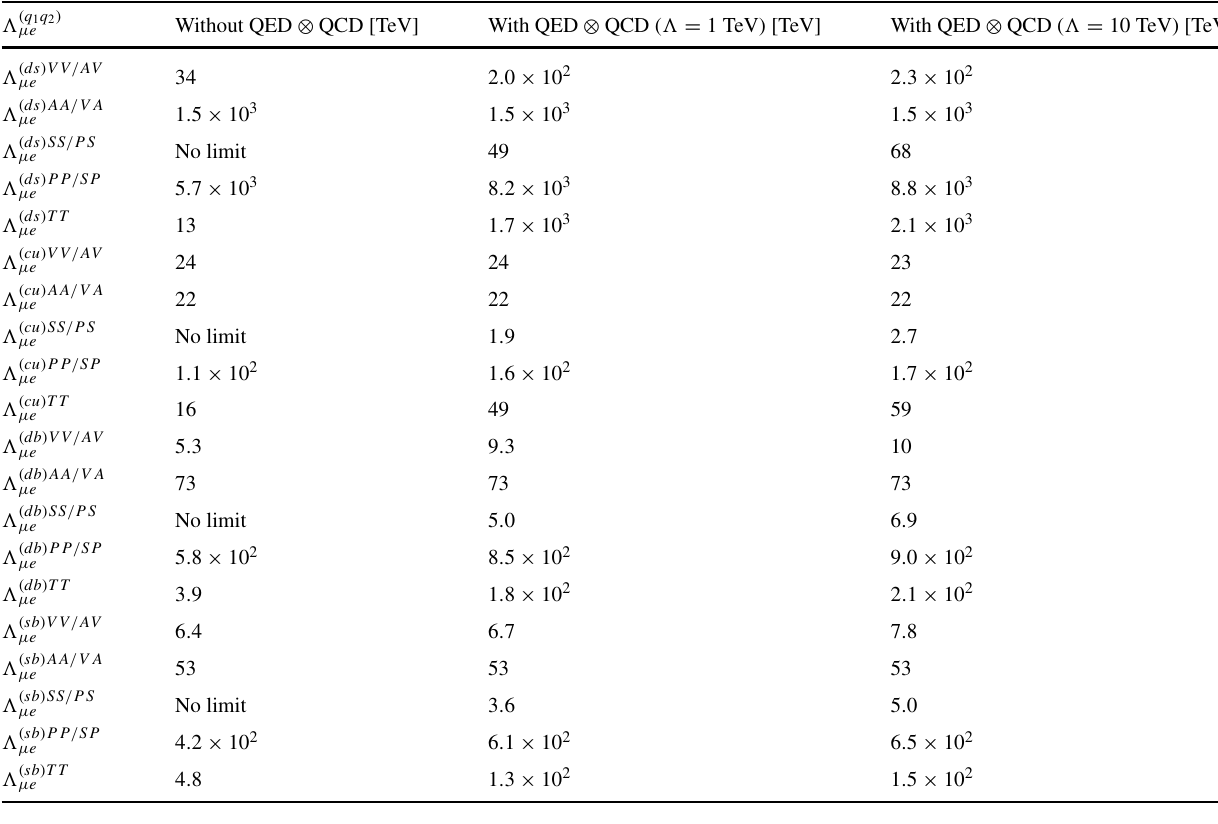
( q 1 q 2 ) AB (cid:13)= q , D 0 , B 0 , B 0 , K ∗ , D ∗ , B ∗ . B ∗ K 0 2 , (cid:2) 1 (cid:2) 2 ( q 1 s s ), listed in Table 1. The L (cid:2) 1 (cid:2) 2 . For the def- (cid:2) ∓ ( M = 1 2